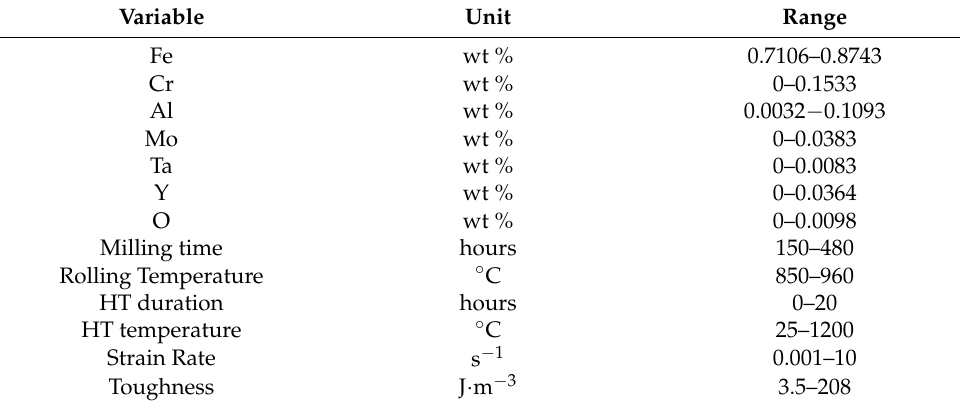
Table 1. The ranges of parameters in the data set